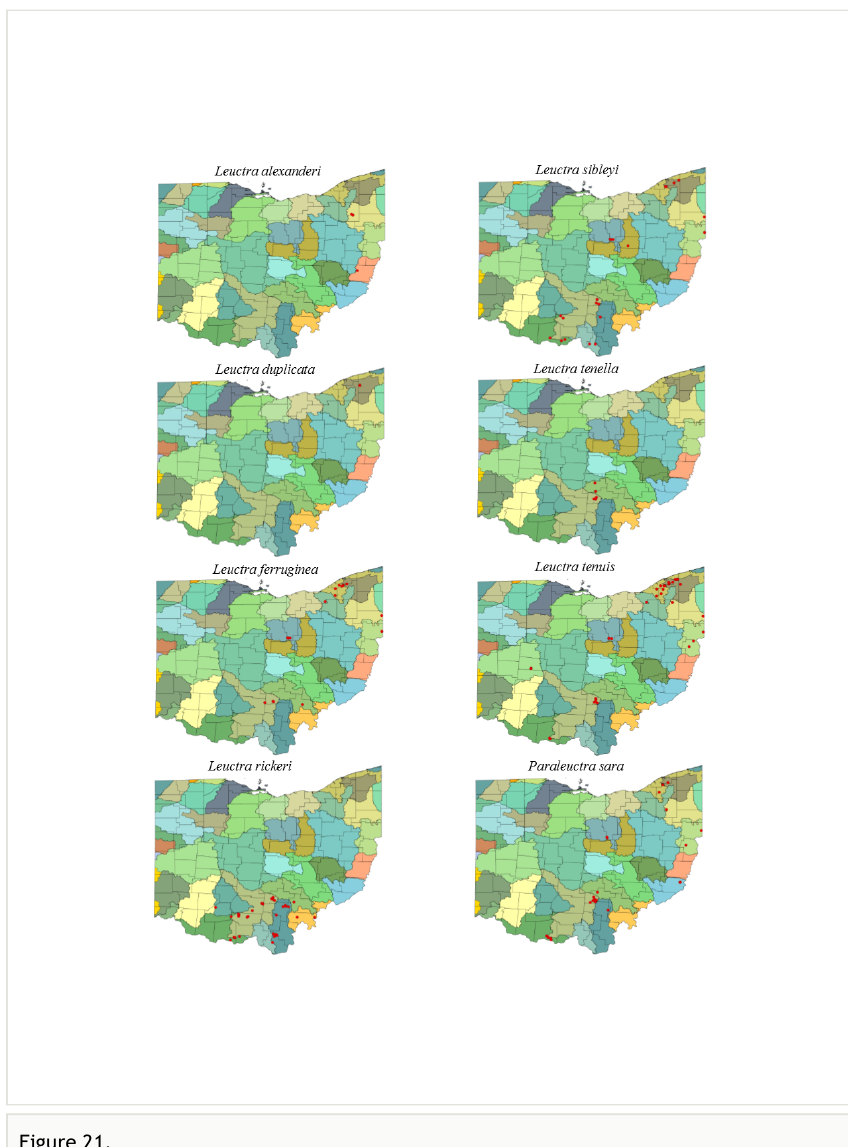
Figure 21. Distribution of Leuctridae in